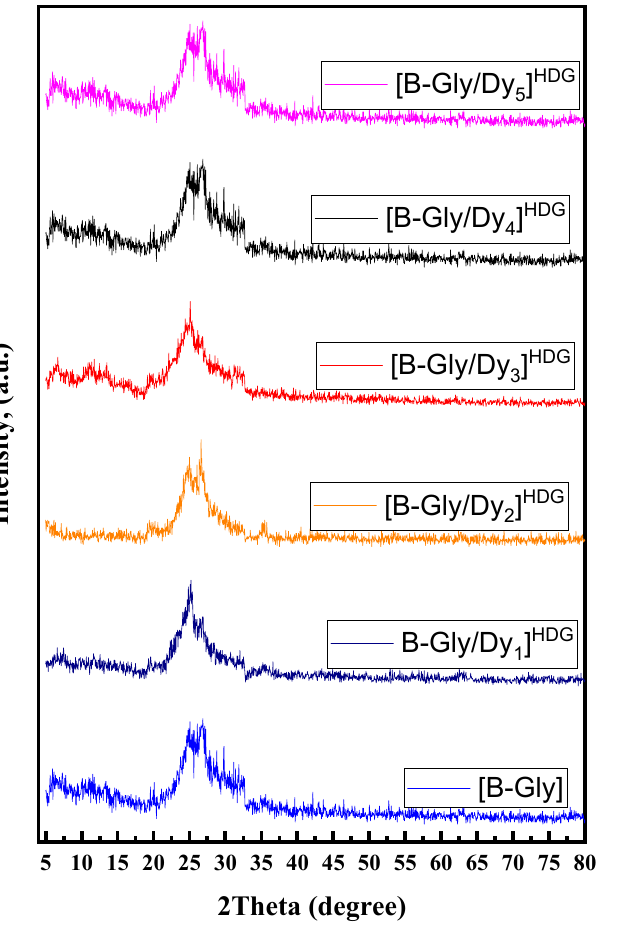
Figure 1. XRD diffractogram for [B-Gly] with different concentrations of Dy 2 O 3 glass system. The XRD patterns in Figure 2a,b demonstrate that [B-Gly] and [B-Gly/Dy 5 ] HHG are nearly identical. The XRD analysis in Figure 2a,b indicates that [B-Gly] and [B-Gly/Dy 5 ] HNC are almost similar at 2 θ = 25.77°. For the different doped concentrations of dysprosium (lanthanides of inert transition elements), two peaks appeared at 2 θ = 6.81° and 2 θ = 13.62°. Table 1 demonstrates the relationship between the miller index (hkl) and the estimated average crystallite size (D), and the full width at half maximum (FWHM) absolute values. A good agreement between the interplanar distances ( d ) and the data in database code amcsd 96-411-7035 [42,43] and 0019483 [44] were observed. Diffraction peaks that were quite close to the [B-Gly] and [B-Gly/Dy] HDG measured data were gener- ated by TDDFT and Crystal Sleuth Microsoft applications [45].